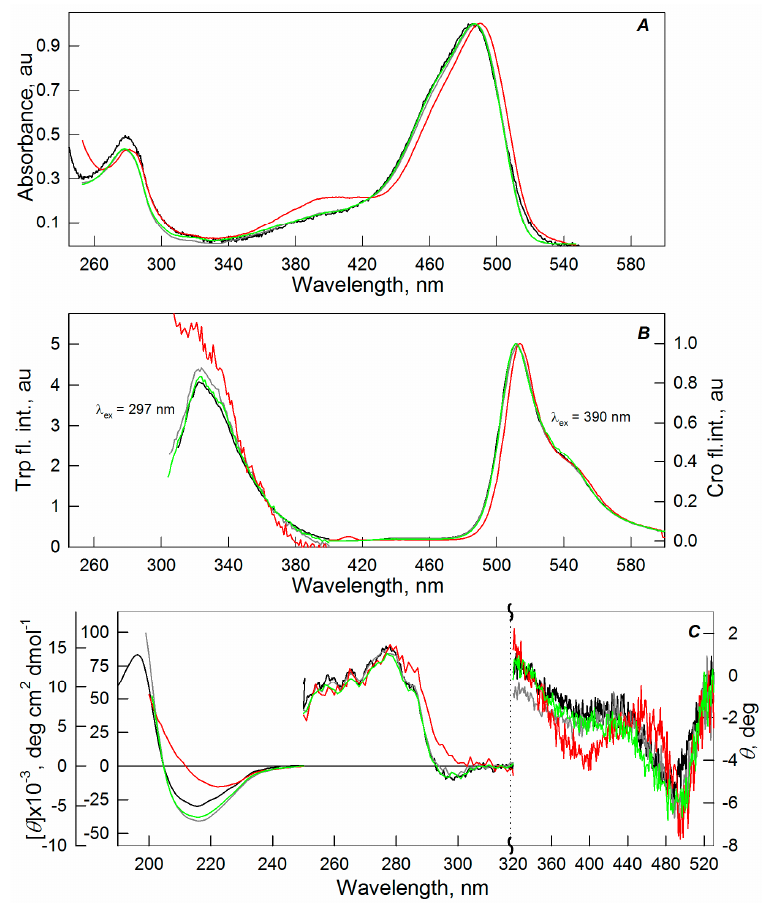
Figure 1. The effect of crowding agent PEG-12000 on the spectral properties of sfGFP. Absorption spectra ( A ); tryptophan fluorescence spectra at λ ex = 295 nm and the fluorescence spectra of the protein chromophore at λ ex = 390 nm ( B ); and CD spectra in the far (the data are represented in units of the molar ellipticity per amino acid residue), near (in units of the molar ellipticity), and visible UV region (in units of the ellipticity) were recorded ( C ). The applied concentrations of PEG-12000 were 8% (green line), 20% (gray line), and 30% (red line). The spectra of sfGFP in the buffered solution (black lines) are shown for comparison.